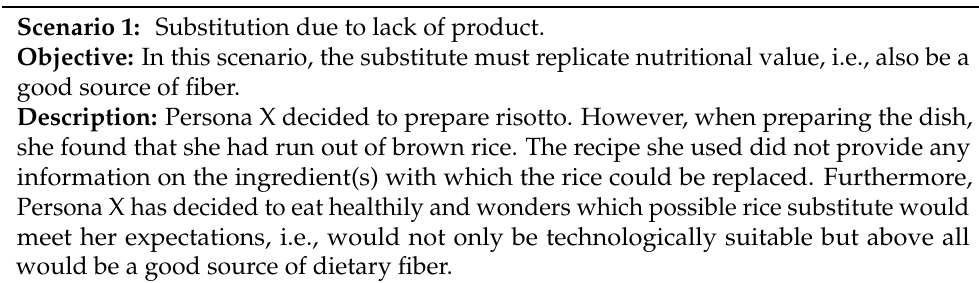
Table 2. Motivating